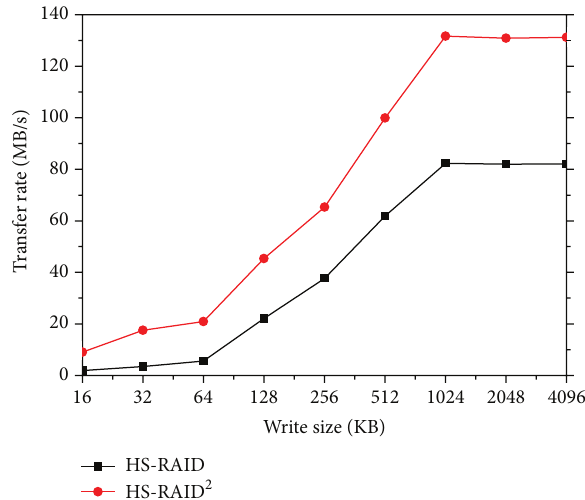
Figure 7: Performance of HS-RAID and HS-RAID 2 (2 disks per group).